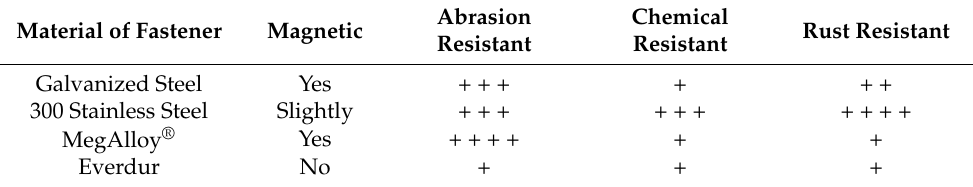
Abrasion Chemical Resistant